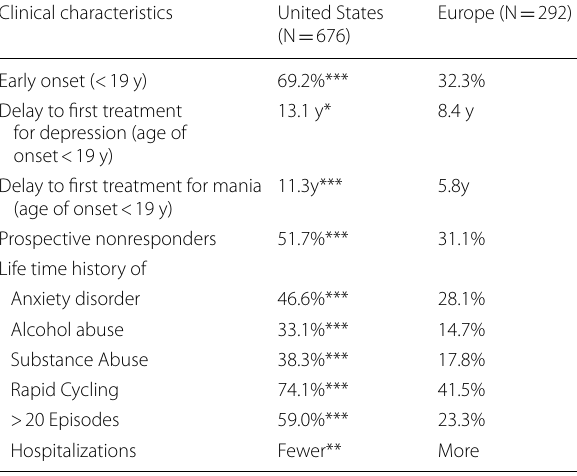
Burden of illness appears significantly higher in the US subjects (*p < 0.05; **p < 0.01; ***p < 0.001) =